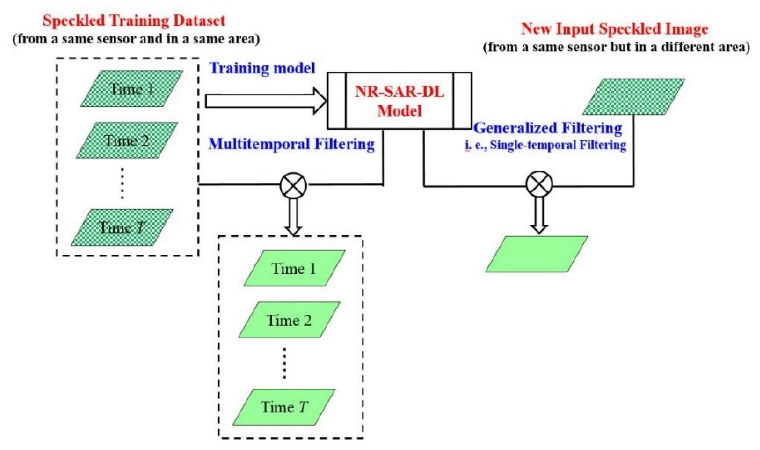
Figure 1. Basic framework of the NR-SAR-DL filter [15].